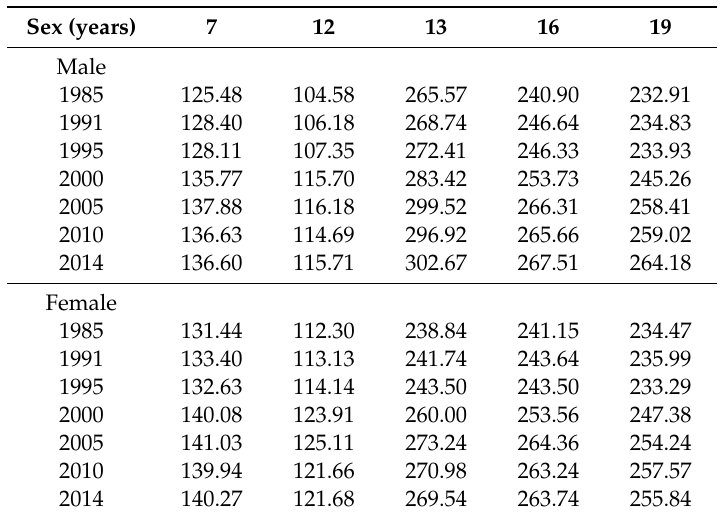
Table 3. Running Time for Children and Adolescents (s),